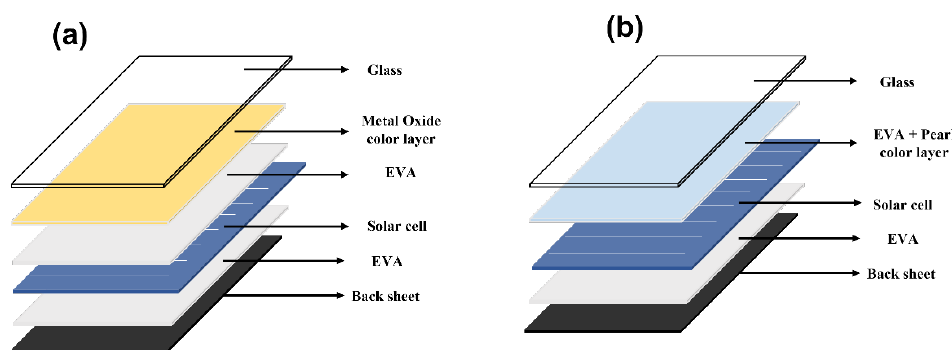
Figure 2. Schematic structure of color glass on solar cell. ( a ) Conventional structure. ( b ) Proposed structure.